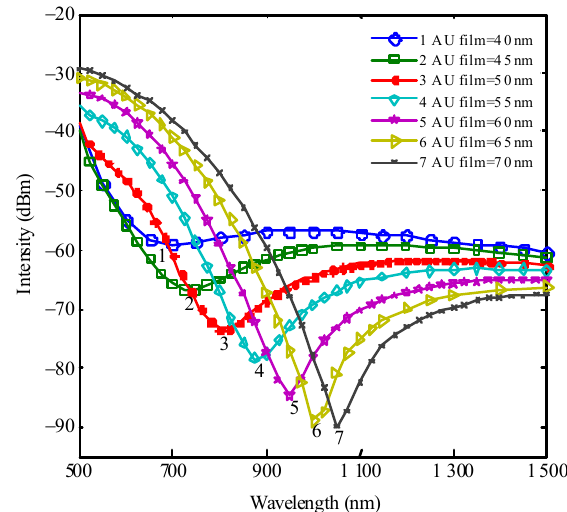
Fig. 3 SPR spectra with different thicknesses of gold film (residual cladding thickness=50 nm, air ring thickness =50 nm, and n a =1.0).